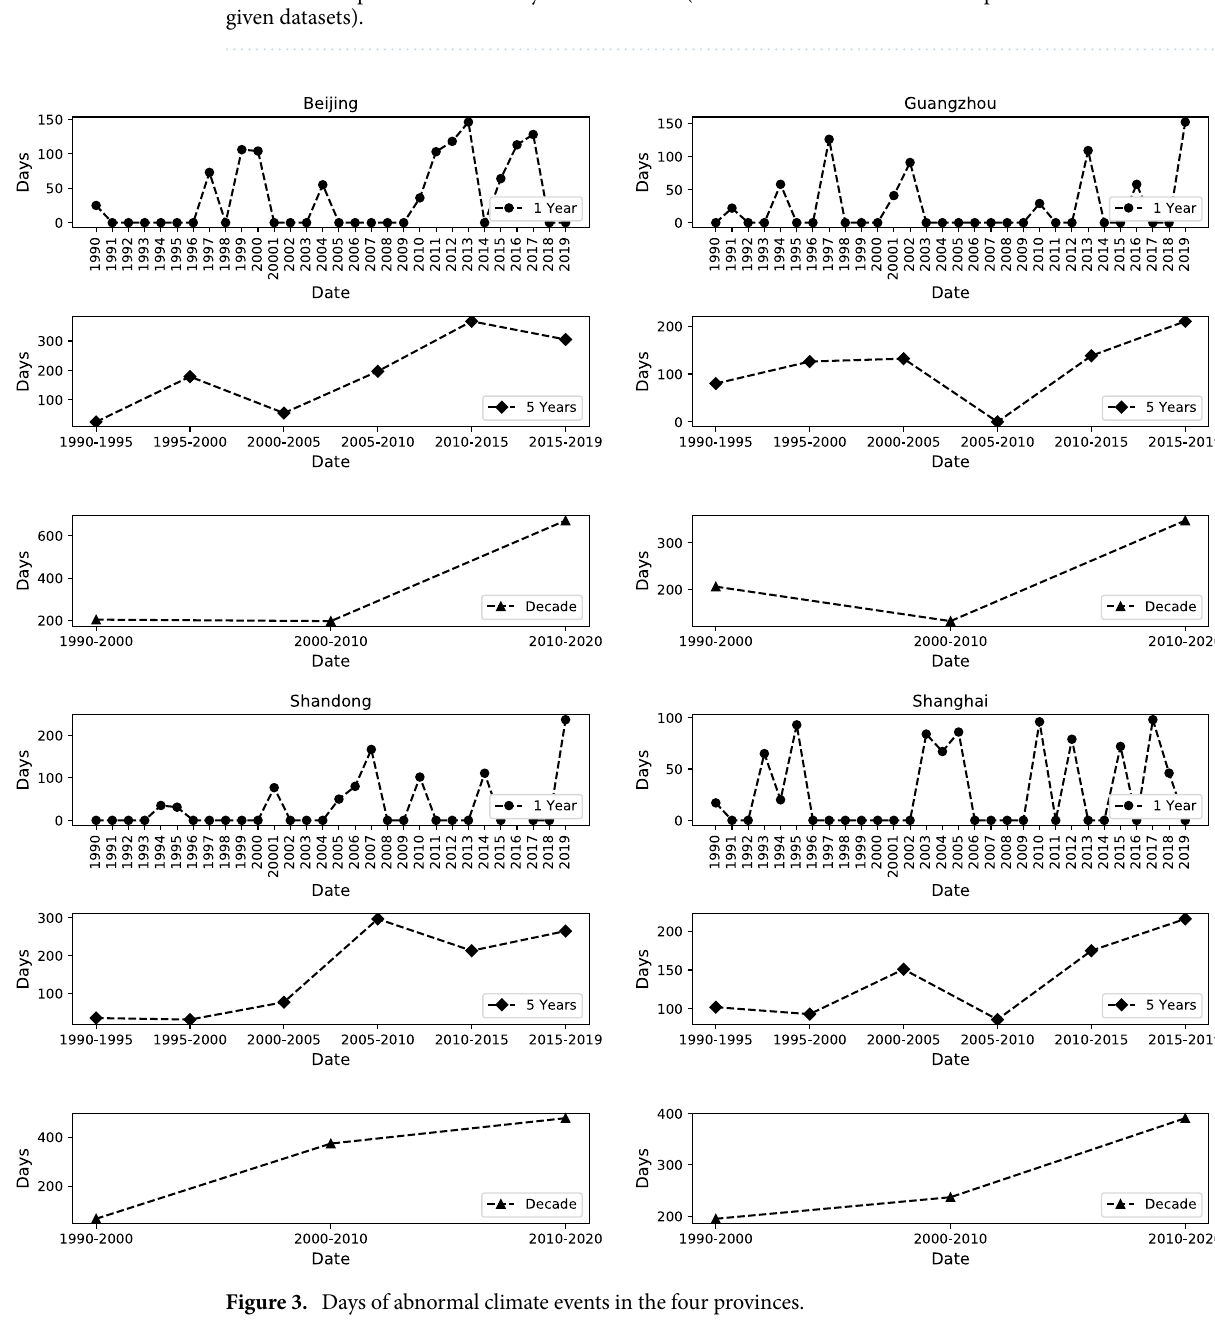
Figure 3. Days of abnormal climate events in the four